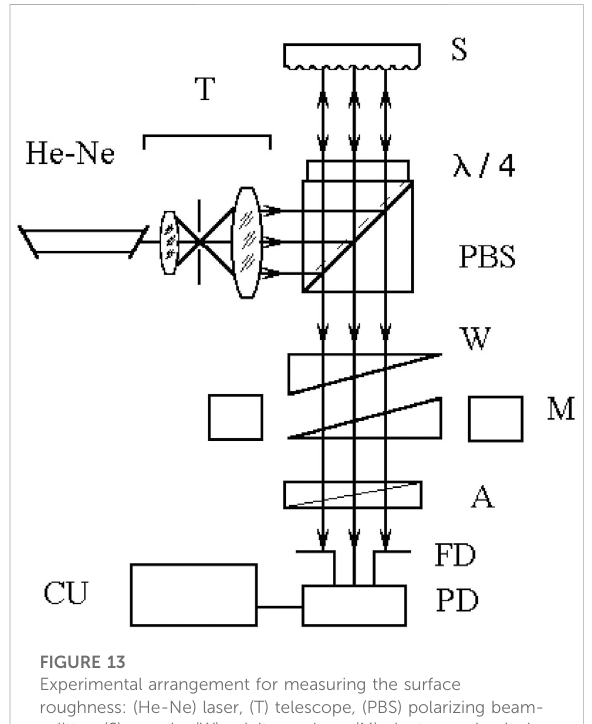
FIGURE 13 Experimental arrangement for measuring the surface roughness: (He-Ne) laser, (T) telescope, (PBS) polarizing beam- splitter, (S) sample, (W) calcite wedges, (M) electromechanical modulator, (A) analyzer, (FD) fi eld-of-view diaphragm, (PD) photodetector, (CU) calculation unit.